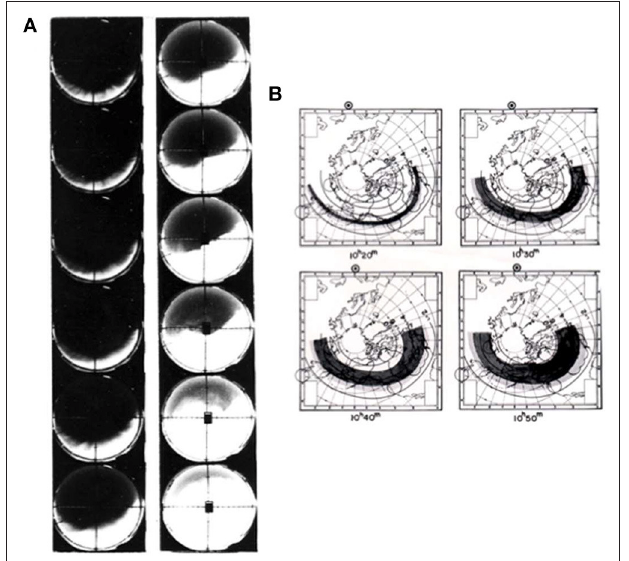
FIGURE 3 | (A) a series of all-sky images during an intense substorm (AE ≈ 2,000 nT) recorded in Fairbanks, Alaska, during the great geomagnetic storm of February 11, 1958; it shows the last part of the great expansion phase observed in Fairbanks (65 ◦ gm. lat.). (B) the expansion phase over the North American Continent on the same day. Similar expansion occurred several times during the storm.